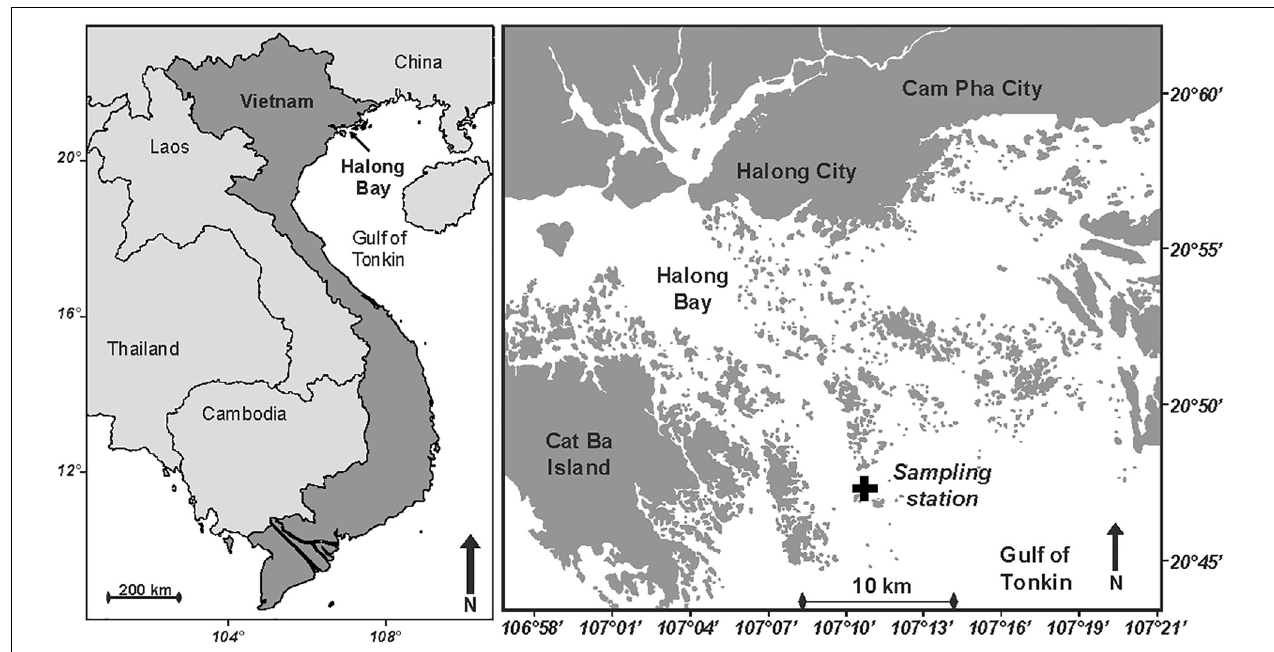
FIGURE 1 | Maps showing the location of Halong Bay in North Vietnam, and the position of the sampling station (20 ◦ 46 (cid:48) 50 (cid:48)(cid:48) N 107 ◦ 10 (cid:48) 16 (cid:48)(cid:48) E; Black